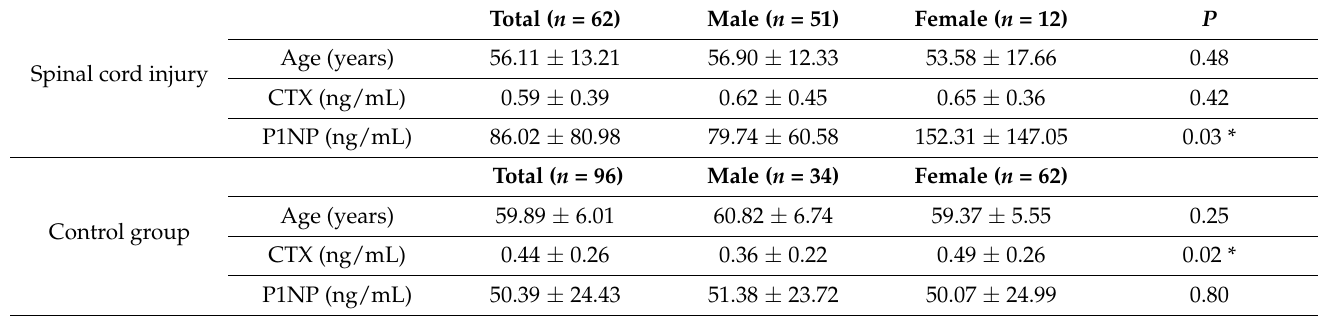
Table 2. Bone biomarker levels according to the sex.